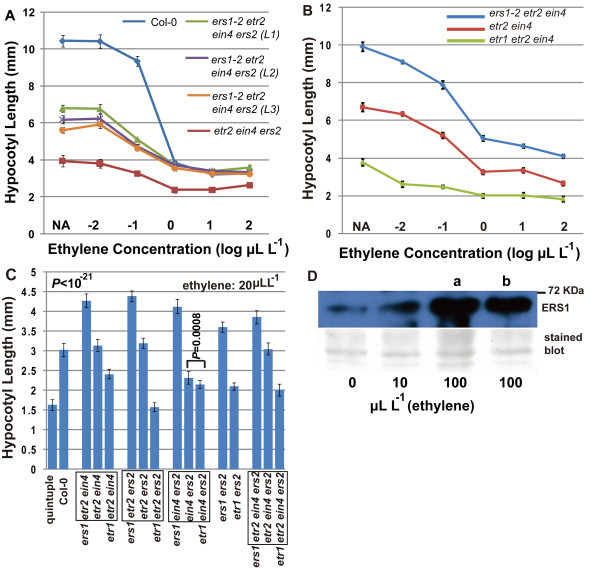
Inhibitory effect of ERS1 on the repression of the ethylene response is not blocked by ethylene. (A), (B) ethylene dose-response curve for two sets of ERS1-lacking mutants. (C) under a high ethylene concentration, ERS1 still exerts an inhibitory effect on seedling hypocotyl elongation. (D) ERS1 accumulation is elevated upon ethylene treatment; a and b represent ERS1 level from two independent wild-type plants. Error bar indicates standard deviation. ERS1: the ERS1 protein. NA: no ethylene treatment. Stained blot: membrane was stained with Coomassie Blue after the immunoassay to indicate relative protein amount. L1, L2, and L3 represent three independently identified isogenic mutants. A molecular weight marker is indicated at the position of 72 kD. Common mutations are highlighted in a box. P: probability of a numerically larger t in Student's t test or LSD-t test.